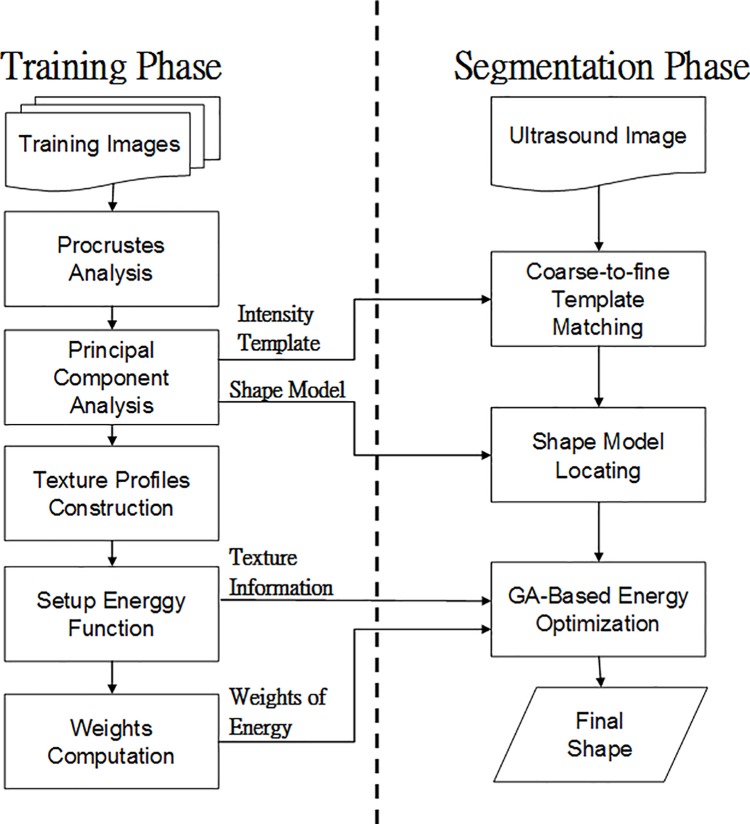
ATASM Flowchart.